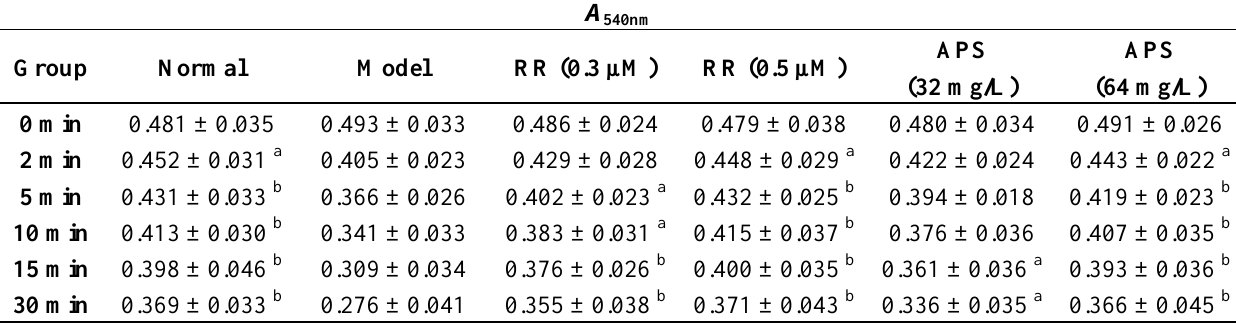
Table 2. The effect of APS on liver mitochondrial permeability transition induced by Ca 2+ (n = 6). Data were expressed as means ± S.D. and statistical differences between groups were analyzed by one-way analysis of variance (ANOVA).